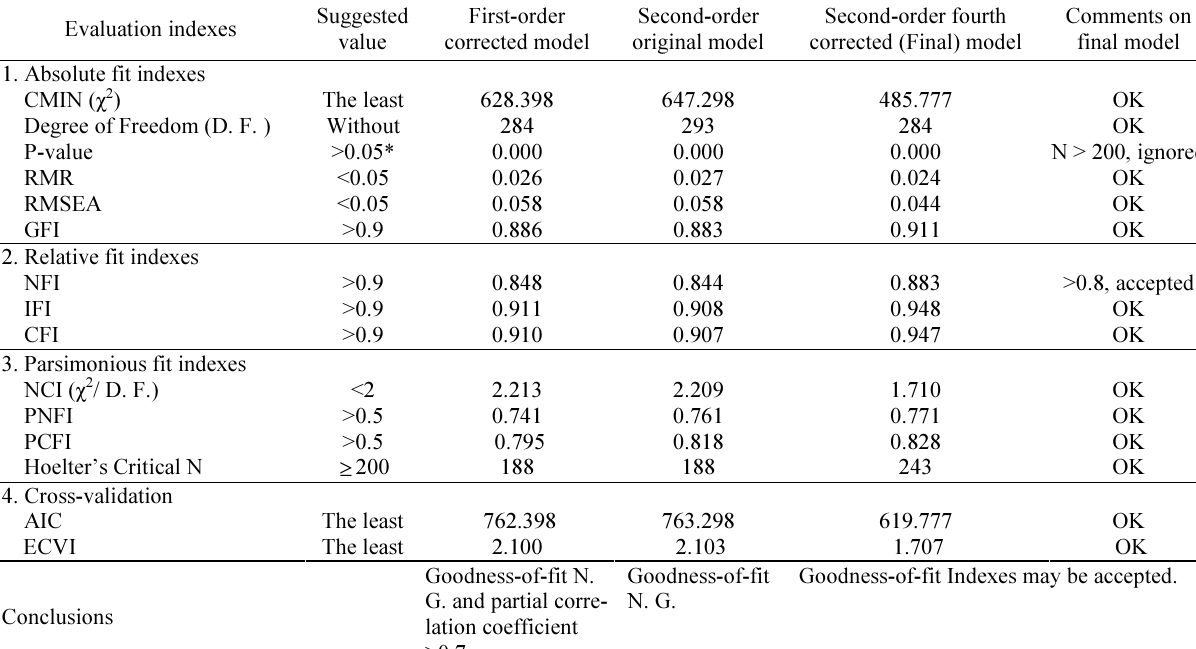
Table 7. Goodness-of-fit measurement of the CFA model Evaluation